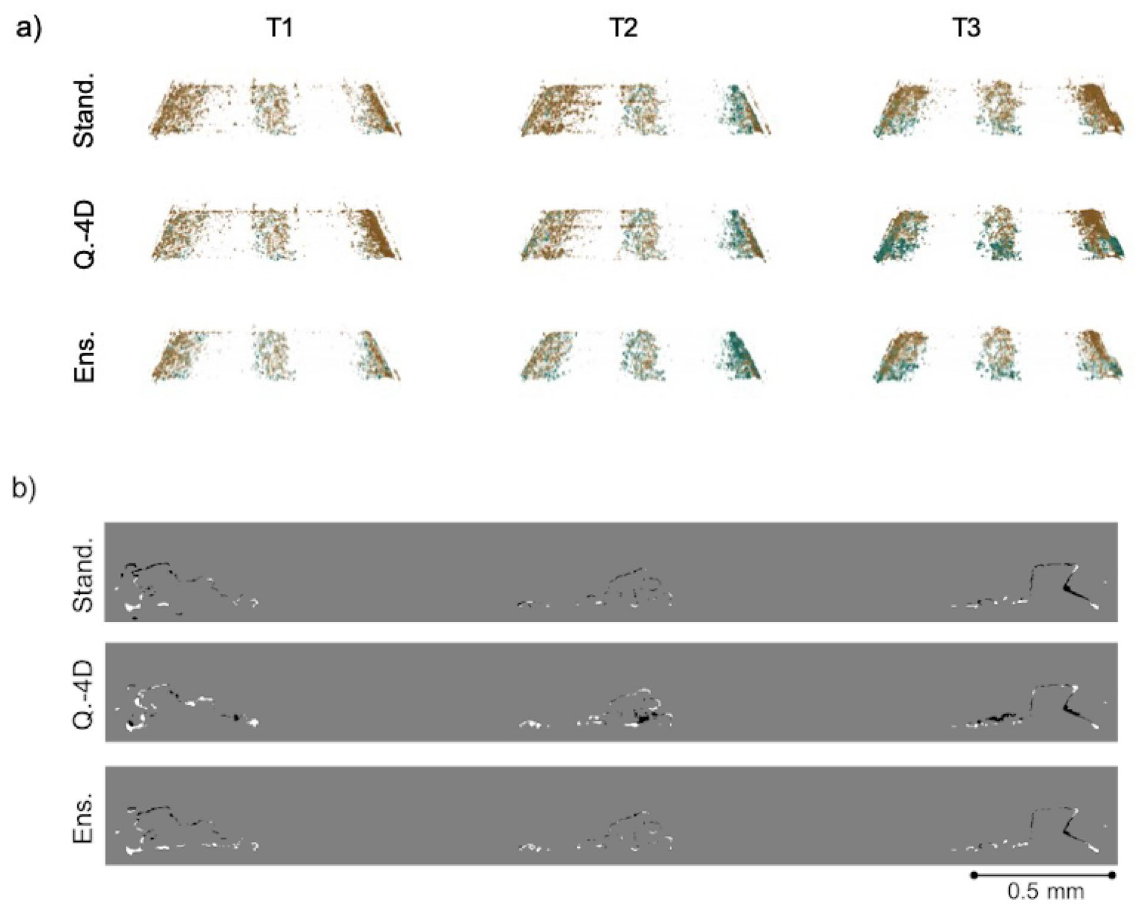
Figure 4. Comparison of the recovered water for the PEFC_2 dataset. The first column presents the time step 25 (T1), the second column time step 37 (T2) and the third column time step 49 (T3). ( a ) Difference volumes between the manual segmentation (ground truth) and SIRT-FBP-MS-D-DIFF water classifications with standard (Stand.), quasi-4D (Q.-4D) and ensemble (Ens.) training schemes of the MS-D network, respectively. The green color corresponds to features present only in the ground truth, orange to features present only in the SIRT-FBP-MS-D-DIFF water classifications. ( b ) Difference slice (slice 563, T3) between the water classification with the networks and ground truth segmentation. The white structures correspond to features present only in the ground truth segmentation, black structures only in the SIRT-FBP-MS-D-DIFF water